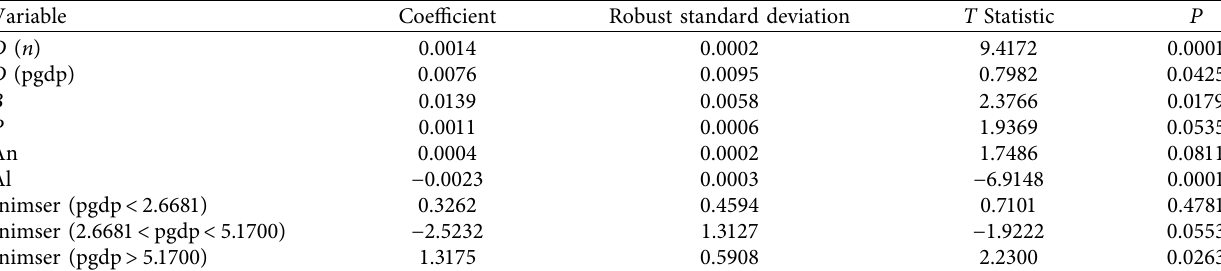
Table 2: Simulation results with urban economic development level as the threshold